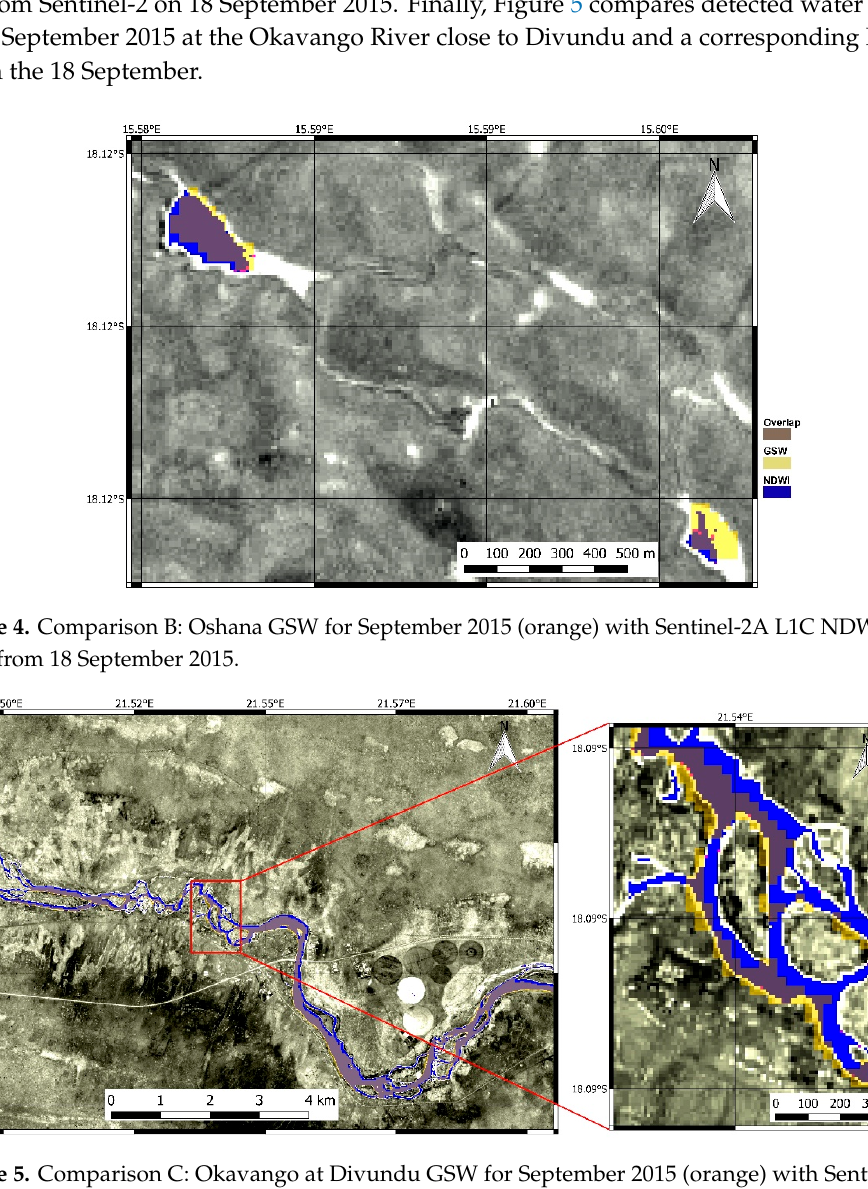
Figure 3. Comparison A: Hardap Dam GSW for September 2015 (orange) with Sentinel-2A Level 1C Normalized Difference Water Index (NDWI) (blue >0.5) from 22 September 2015 and overlap (grey).